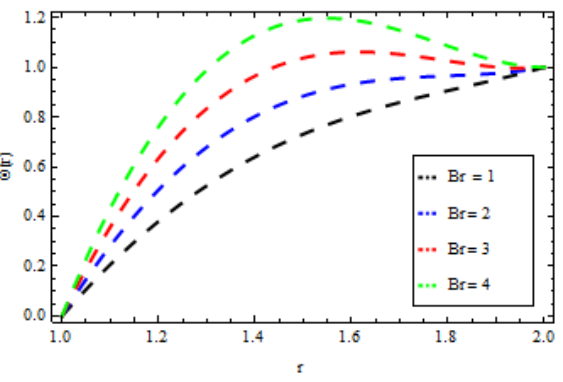
Figure 8. Temperature profile for various values of Br when δ = 2, β = 0.2, M = 0.2, K = 0.1.